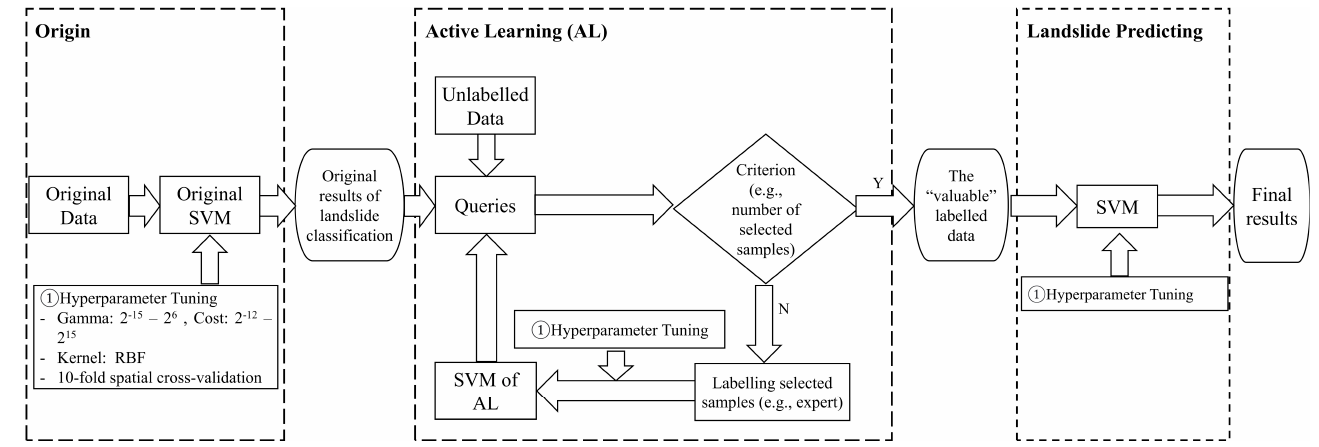
Figure 1. Overview of the workflow of active learning for landslide detection based on the